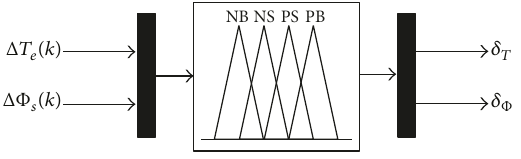
Figure 6: Fuzzy logic NMP-DTC technique.